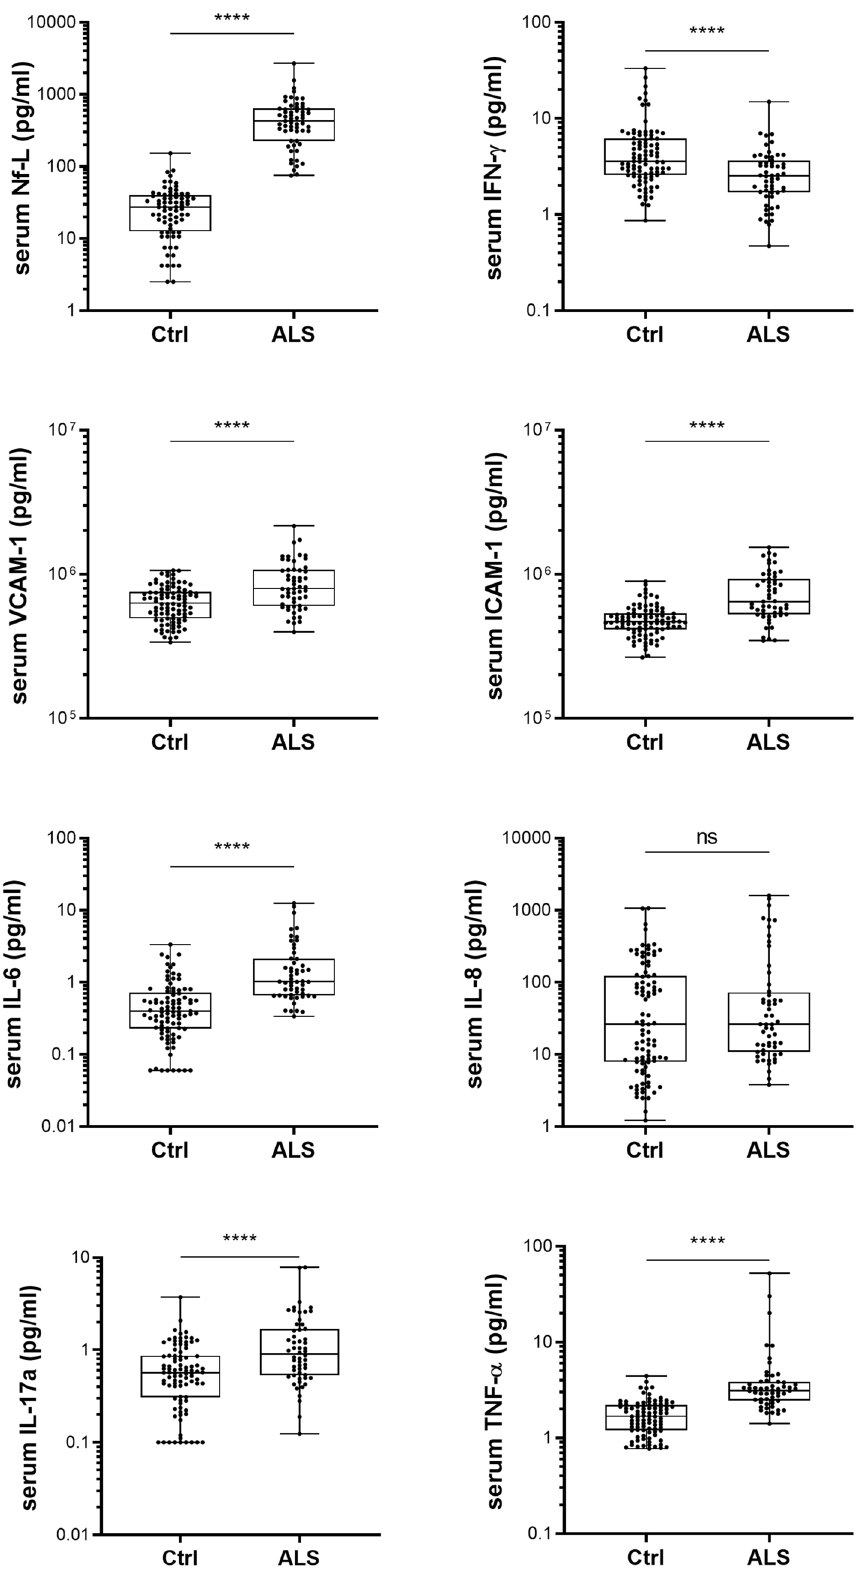
Figure 1. Neuroinflammation biomarkers in serum samples of ALS patients. Levels of biomarkers in serum from ALS patients (ALS) compared to serum sample from the control group (Ctrl). Mann Whitney test significance levels are indicated on graphs (**** p <